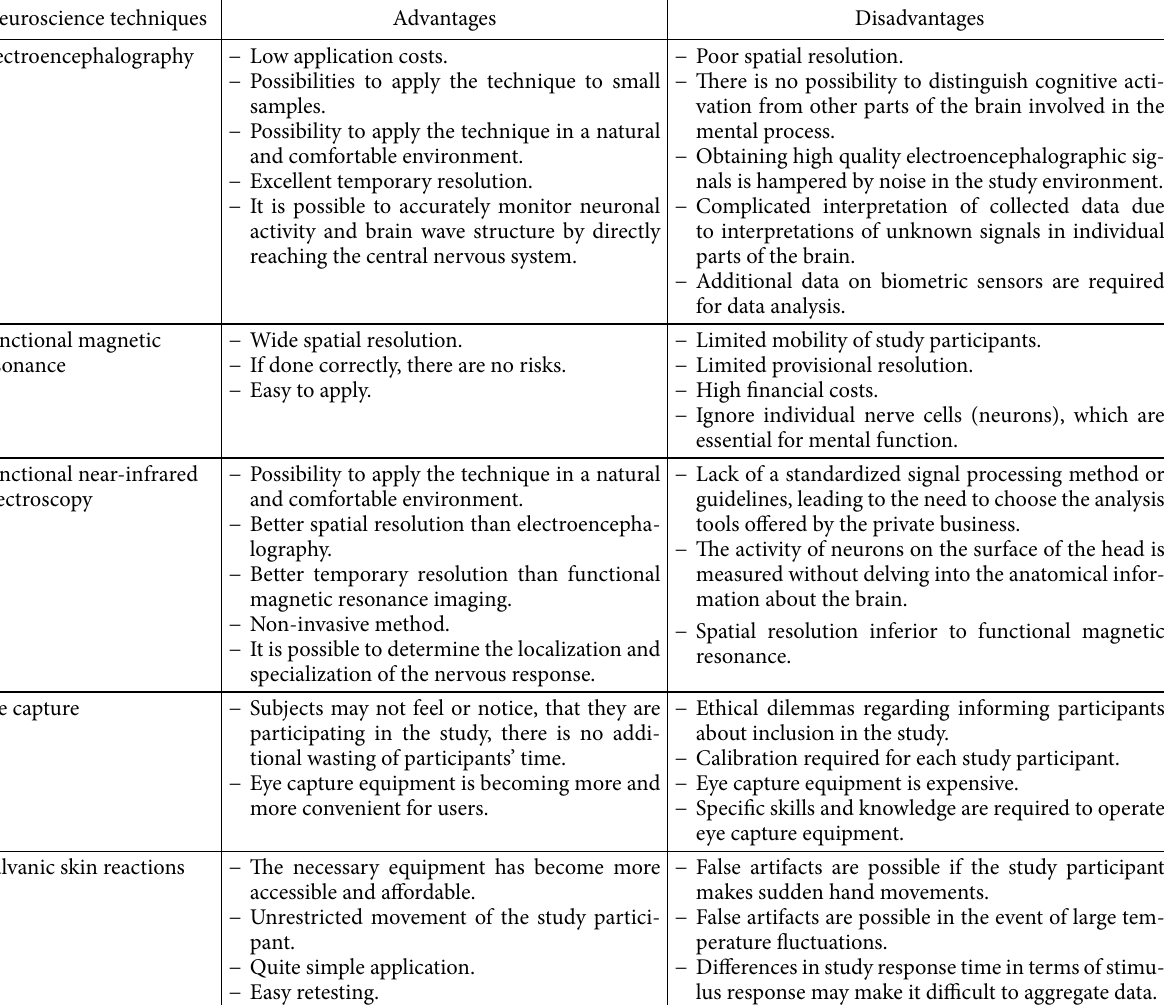
Table 4. Advantages and disadvantages of neuroscience